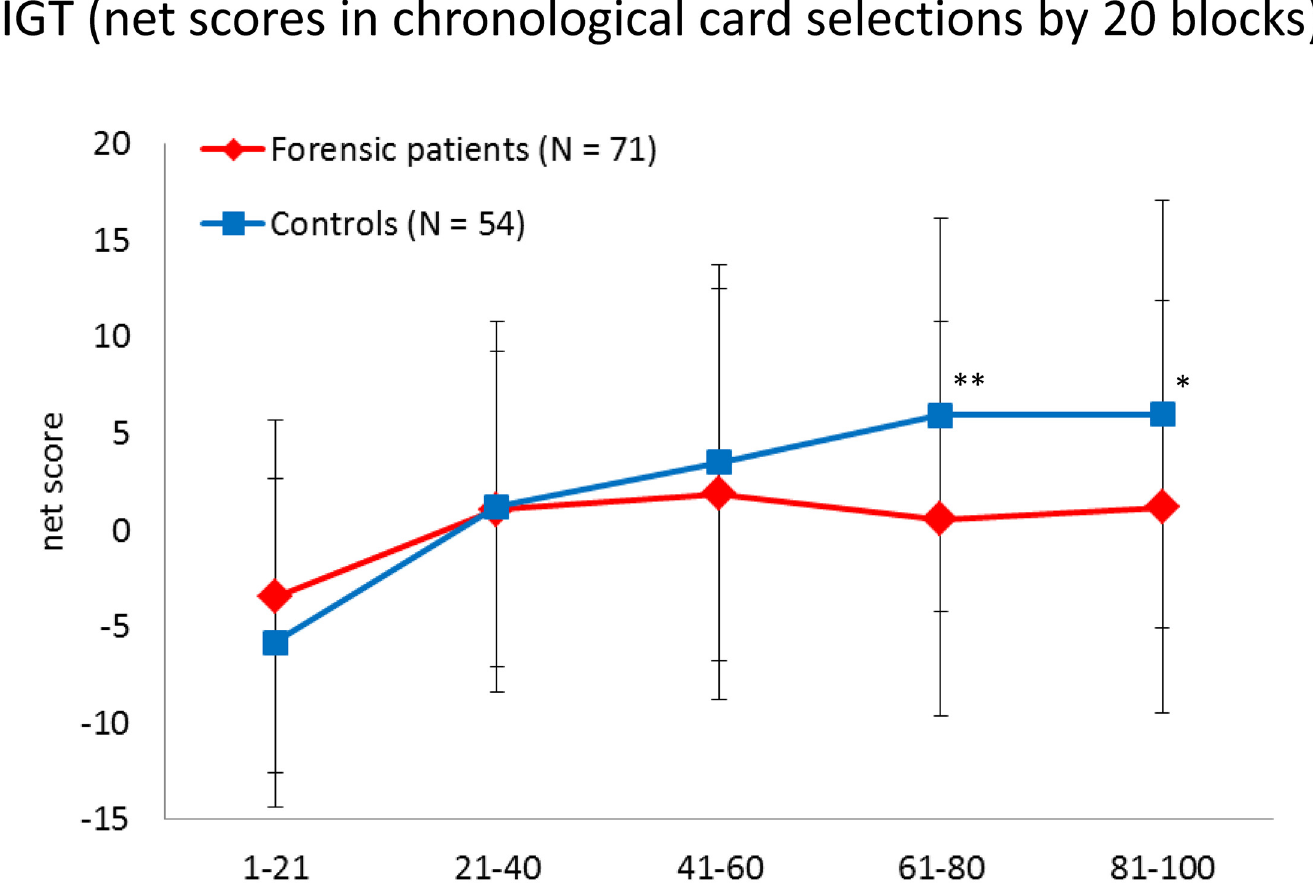
Fig 2. The IGT net scores for the 5 blocks for forensic patients and healthy controls. Mean ± SD are given. * p < 0.05, ** p < 0.01.